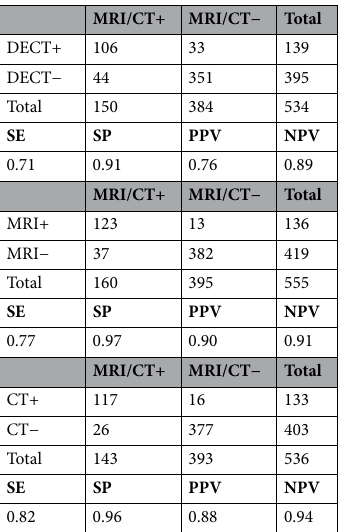
Table 2. Contingency table analysis of the presence of foraminal stenosis for DECT, MRI, and CT with both MRI and standard CT as standard of reference. Data are given with 95% confidence intervals. SE sensitivity, SP specificity, PPV positive predictive value, NPV negative predictive value, MRI magnetic resonance imaging, CT computed tomography, DECT dual-energy computed tomography, + discoid or mixed stenosis in MRI or osseous or mixed stenosis in standard CT, − discoid stenosis in standard CT, osseous stenosis in MRI, or no stenosis.